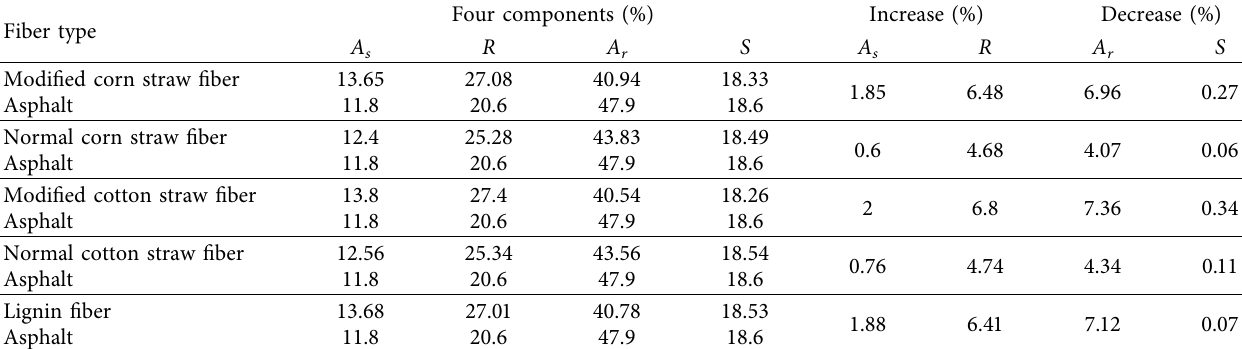
Table 5: Changes in four components of straw fber asphalt